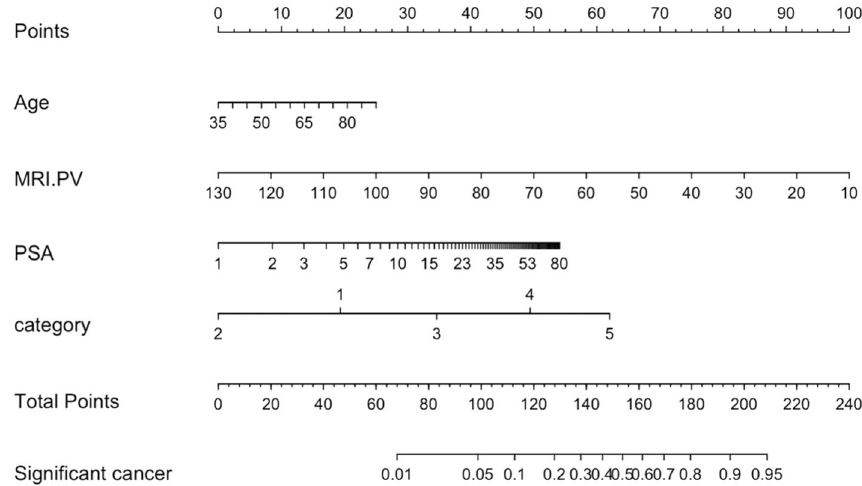
Figure 1. Risk model to predict sPC including age, PSA, PV and bpMRI PI-RADS score .